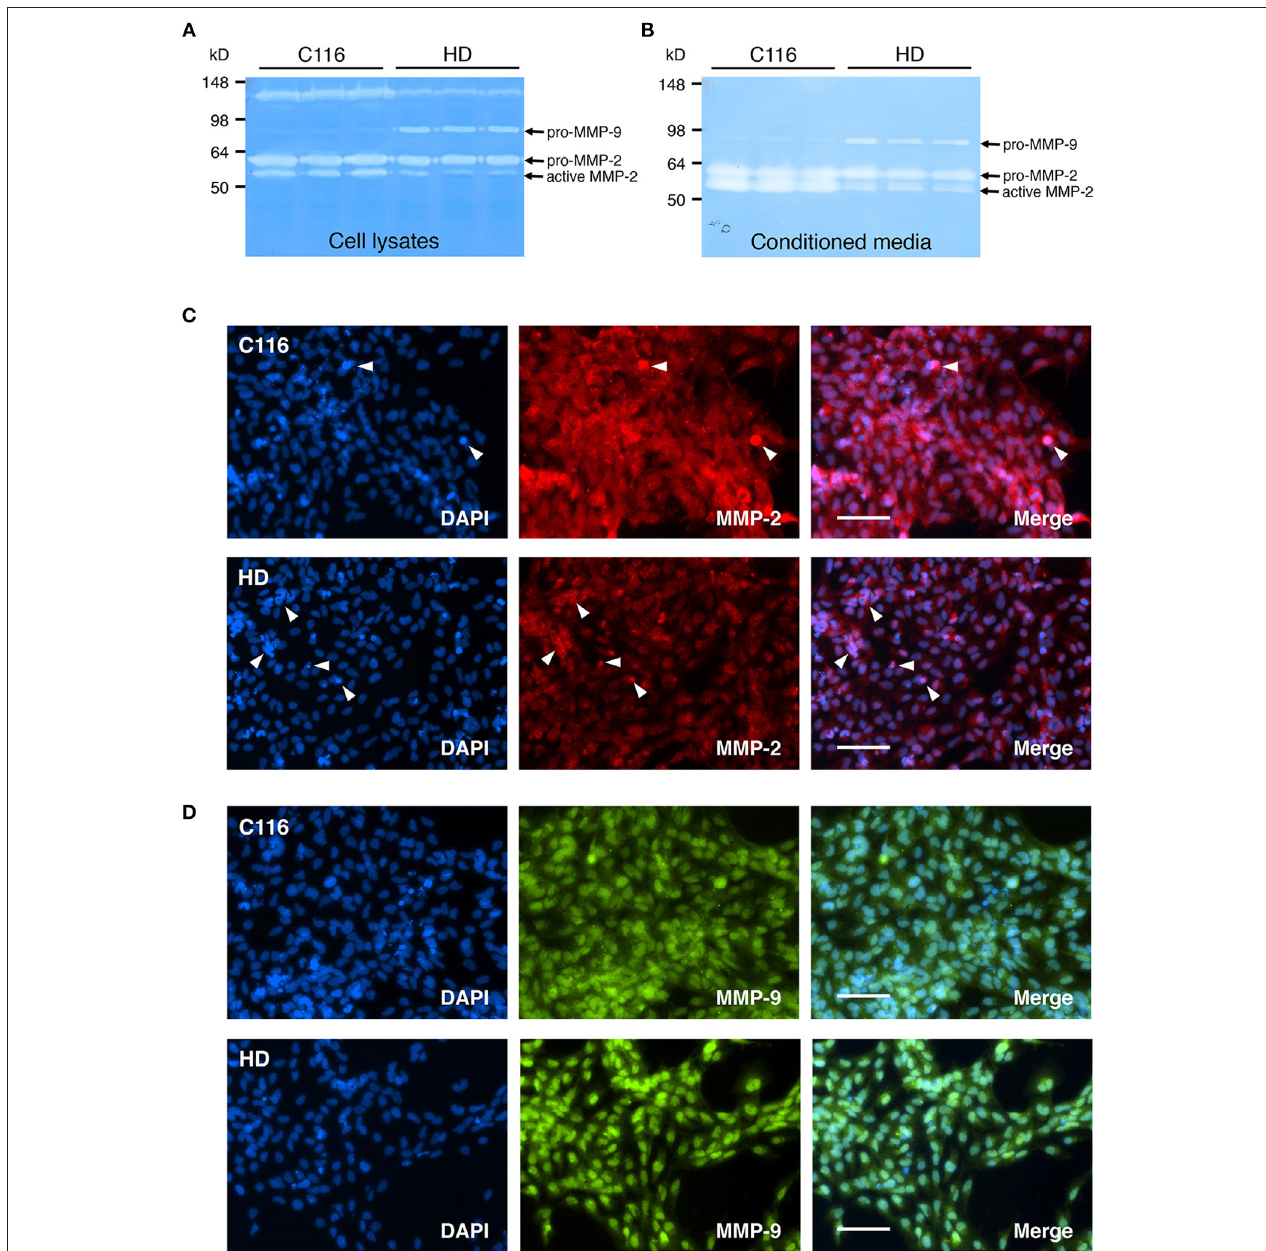
FIGURE 4 | Expression of MMP-2 and MMP-9 (Gelatinases) is altered in HD-NSCs. Gelatin zymogram of C116- and HD-NSC lysates (A) shows increased activity of pro-MMP-9 in HD-NSCs, which is also extracellularly secreted into the conditioned media (B) . In contrast, decreased production of active-MMP-2 is observed in samples prepared from HD-NSCs when compared to C116-NSCs. Immunofluorescence analysis using anti-MMP-2 (C) and anti-MMP-9 (D) antibodies confirms these findings and reveals strictly nuclear localization of both MMP-2 and -9 in HD-NSCs. Strongly increased MMP-2 expression was also found in association with apoptotic cells (white arrowheads in C ). Scale Bars: 100 µ